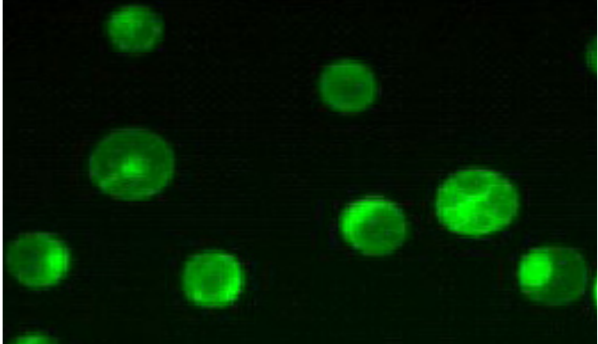
Fig. 1. Viable microspores on variant V5 (FDA staining - fluo- rescence microscope 100x)